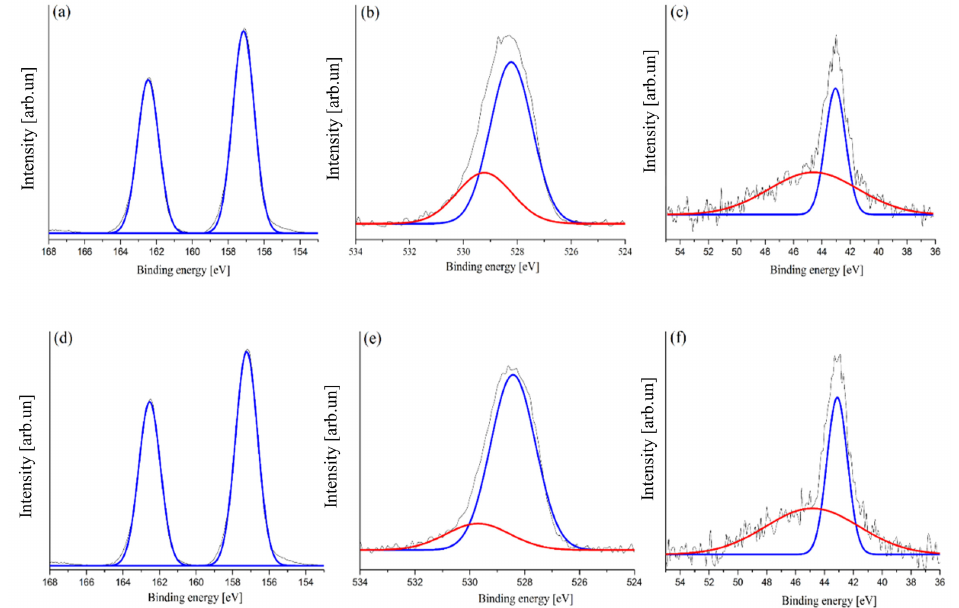
Figure 8. Magnification of high-resolution XPS spectra of Bi 2 O 3 after the adsorption of As(V) in the region ( a ) of Bi 4f 7/2 -Bi 4f 5/2 (154–168 eV), ( b ) O 1s (524–534 eV), and ( c ) As 3d 5/2 -3d 3/2 (54–36 eV) and after the adsorption of the As(III) in the region ( d ) of Bi 4f 7/2 -Bi 4f 5/2 (154–168 eV), ( e ) O 1s (524–534 eV), and ( f ) As 3d 5/2 -As 3d 3/2 1s (54–36 eV). Red and blue curves represent the peaks components. After both As(V) and As (III) adsorption, Bi 4f 7/2 and Bi 4f 5/2 were composed by only one component centered at 157.3 eV and 164.1 eV, respectively, while oxygen signal peaks